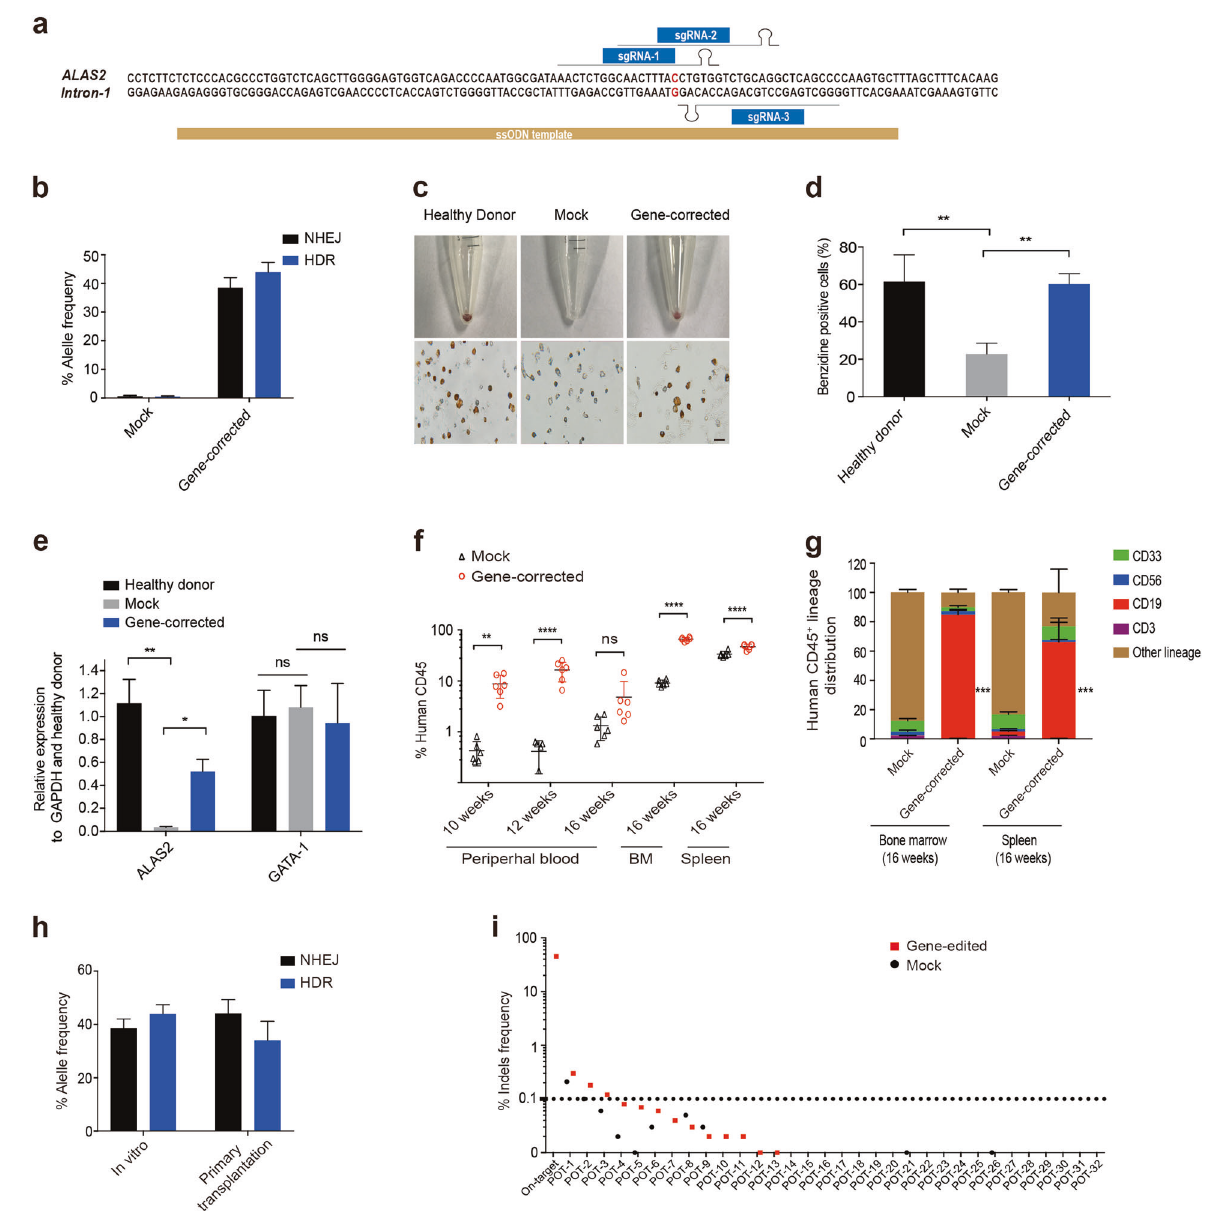
Fig. 1 ALAS2 gene correction in CD34 + HSPCs from XLSA patients. a Schematic representation of sgRNAs and ssODN template designs near the mutations in intron 1 of ALAS2 (uppercase, red). b ALAS2 gene correction in CD34 + HSPCs from XLSA patients using Cas9 mRNA, sgRNA-1 and ssODN. The allele frequencies of HDR and NHEJ were detected by NGS analysis. Mock: unedited CD34 + HSPCs from XLSA patients. c Erythroid cell pellets, benzidine staining after 18 days of differentiation. Scale bar = 20 μ m. d The percentage of benzidine-positive cells. e ALAS2 and GATA1 mRNA expression in erythroid cells was analyzed by RT-qPCR after 18 days of differentiation, and the results are normalized to those in healthy donor cells. GAPDH served as the internal control. Mock and gene-corrected indicate erythroid cells derived from unedited and edited CD34 + HSPCs from XLSA patients, respectively. Healthy donor indicates normal CD34 + HSPCs from granulocyte colony-stimulating factor (G-CSF)-mobilized CD34 + HSPCs. f Human CD45 + cell reconstitution was evaluated in the peripheral blood, bone marrow, and spleen of NPG mice transplanted with gene-corrected CD34 + HSPCs; unedited cells were transplanted as the mock control. n = 6 mice per group. g Lineage distribution of human CD45 + cells in the bone marrow and spleen of primary recipient mice 16 weeks after transplantation. h Gene correction rate in bulk transplanted cells at the time of engraftment (in vitro) and in bone marrow cells at 16 weeks post transplantation. The HDR and NHEJ rates were evaluated by NGS analysis. i Potential off-target sites were identi fi ed by in silico prediction and unbiased Digenome-seq and then directly interrogated in hiPSCs by targeted PCR ampli fi cation and NGS analysis. Off-target sites were plotted on the X axis grouped as an on-target site or potential off-target (POT) site and then sorted by the mean indel percentage. The number of indels detected by NGS using ampliCan is plotted on the Y axis on a log scale. All in vitro experiments were performed independently in triplicate. All data are shown as the mean ± SD. * P < 0.05, ** P < 0.01, *** P < 0.001, **** P < 0.0001